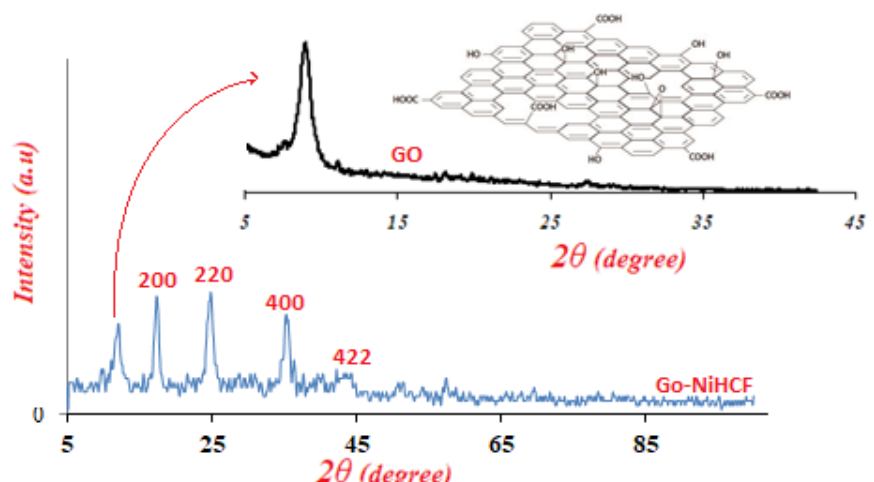
Fig.1 XRD pattern of GO-Nickel hexacyanoferrate and GO (inset) samples (at 25 °C and 24